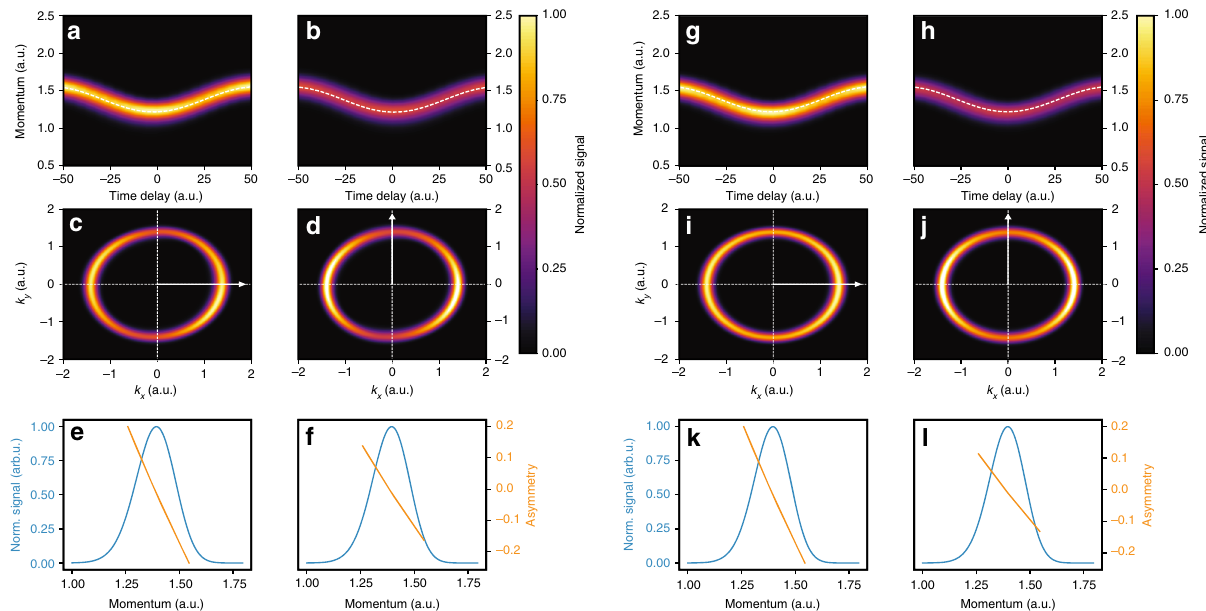
Fig. 3 IR-streaked photoionization observables used in the reconstruction. Numerical spectra and observables for the laser-assisted photoionization of the hydrogen atom by the pulse in Fig. 2a ( a - f ) and by the pulse in Fig. 2b ( g - l ). a , b , g , h Normalized streaking trace, measured along the IR polarization axis. c , d , i , j Angularly resolved IR-streaked signal of the photoelectron distribution at the maximum of the IR electric fi eld. The white arrow indicates the polarization direction of the IR laser. e , f , k , l Photoelectron asymmetries (orange curves) and average signals (blue lines) extracted from the angularly resolved spectrum on top in the direction perpendicular to the laser polarization axis. The orientation of the IR polarization axis with respect to the major axis of the XUV ellipse is parallel in ( a ), ( c ), ( e ), ( g ), ( i ), and ( k ), and perpendicular in panels ( b ), ( d ), ( f ), ( h ), ( j ), and ( l